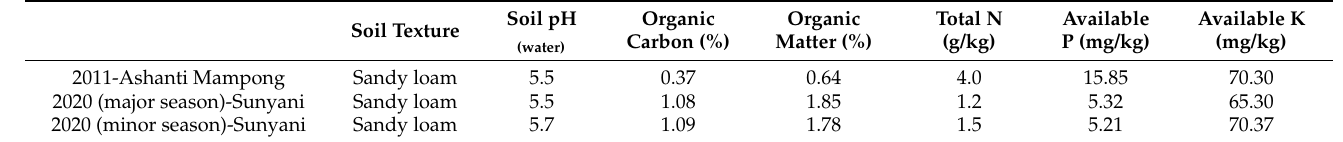
Table 1. Soil and poultry manure physico-chemical properties of experimental locations in Ghana. Soil